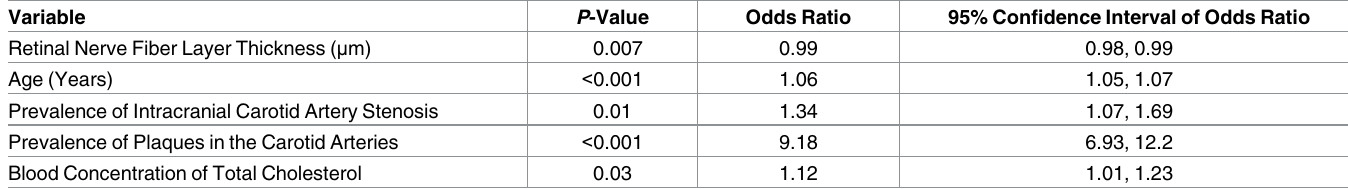
Table 3. Associations between the prevalenceof extracranial carotid arterystenosis and retinal nerve fiber layer thickness ( μ m) (Binary multivari- ate regression analysis) in the asymptomatic polyvascular abnormalities in community